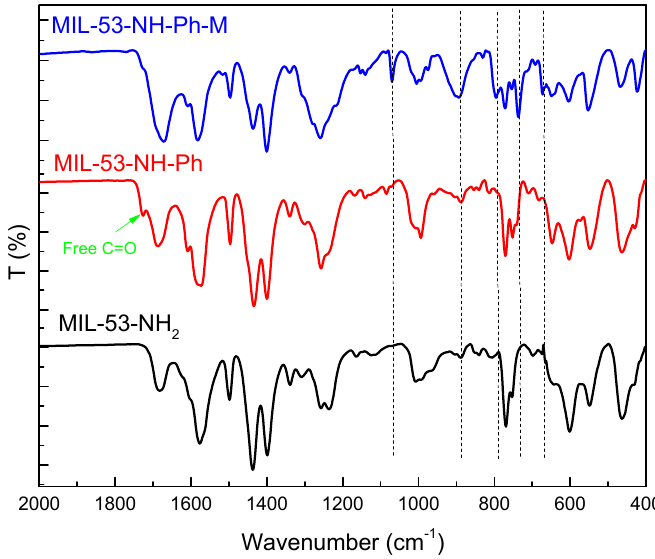
Figure 3. FTIR of MIL − 53-NH 2 , MIL − NH-Ph, and MIL − 53-NH − Ph − M.